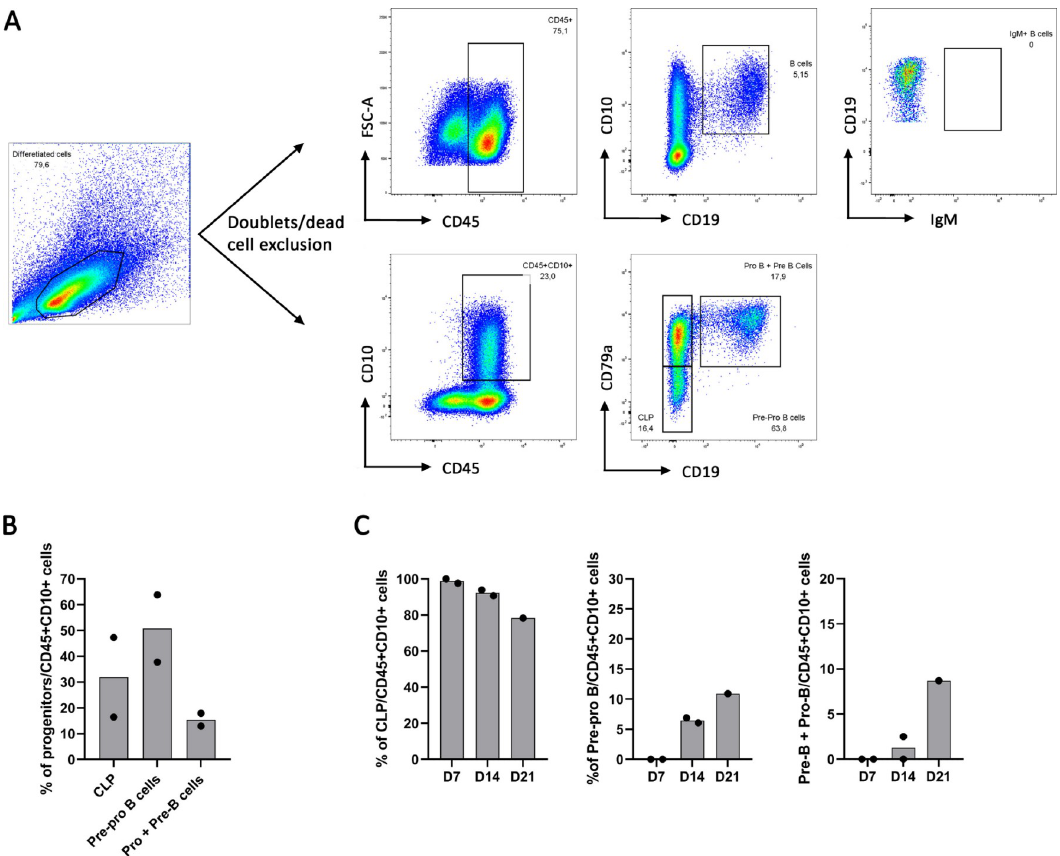
Fig 4. Gating strategy of B cell progenitors. (A) B cell characterization during B cell differentiation of UCB CD34 + cells using CD10 + CD19 + total B cells gated on CD45 + (upper panel) and using CD79a - CD10 - CLP, CD79a + CD10 - Pre-pro-B cells and CD79a + CD19 + both Pro-B and Pre-B cells gated on CD45 + CD10 + (lower panel). (B) B cell progenitors proportion in 2 independent experiments. (C) B cell progenitors proportion at Day 7 (D7), 14 (D14) and 21 (D21) of B cell differentiation from hESC-derived CD34 + (n = 1 or 2 independent